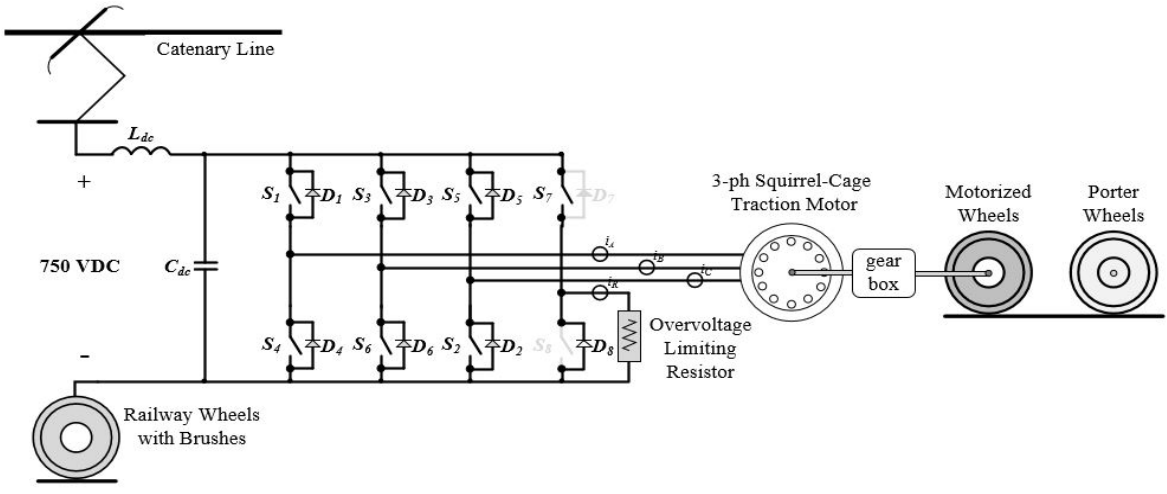
Figure 1. Circuit diagram of a three-phase voltage-source traction motor converter for light rail public transportation systems.